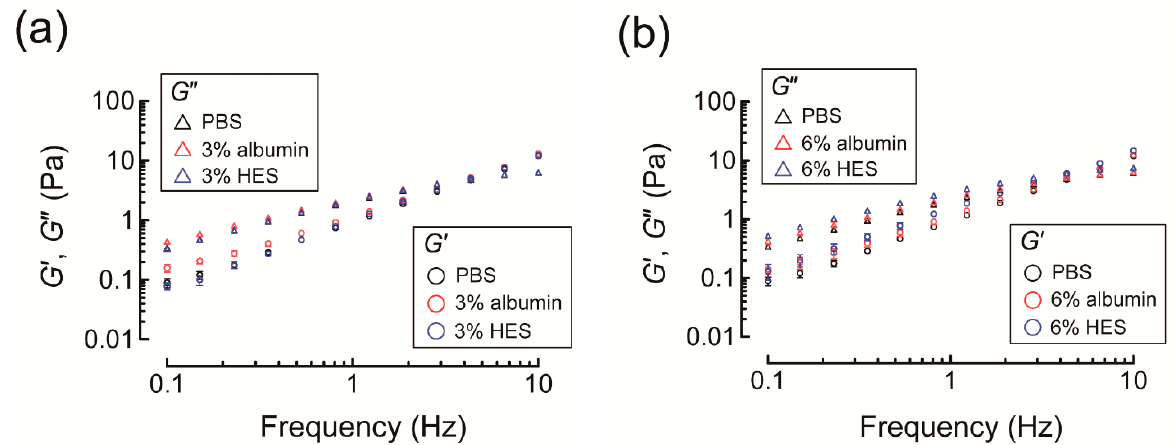
Figure 8. ( a ) Comparison of storage ( G ′ ) and loss ( G ″ ) shear moduli of 0.5% sodium hyaluronic acid (NaHA) dissolved in phosphate buffered saline (PBS) or 3% colloid solution (i.e., albumin or hydroxyethyl starch (HES)). ( b ) Comparison of G ′ and G ″ of 0.5% NaHA dissolved in PBS or 6% colloid solution (i.e., albumin or HES). Values are expressed as mean and standard deviation ( n = 6 or 7).